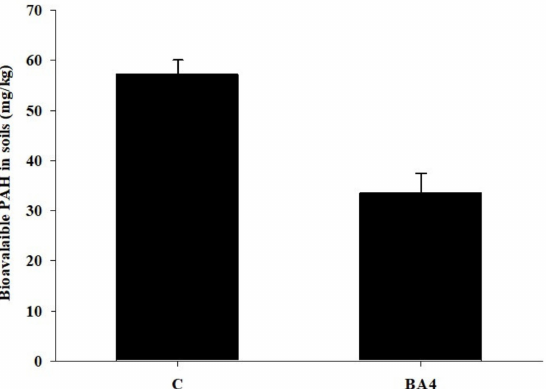
Figure 3. Comparison of the rate of bioavailable PAH between the fungal biotreated (BA4) soil after 8 months of incubation and untreated soil